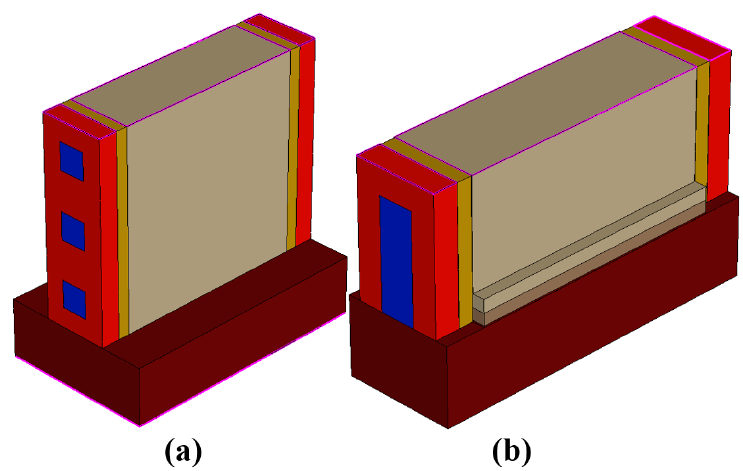
Figure 6. ( a ) NWFET structure in the TCAD model; ( b ) FinFET structure in the TCAD